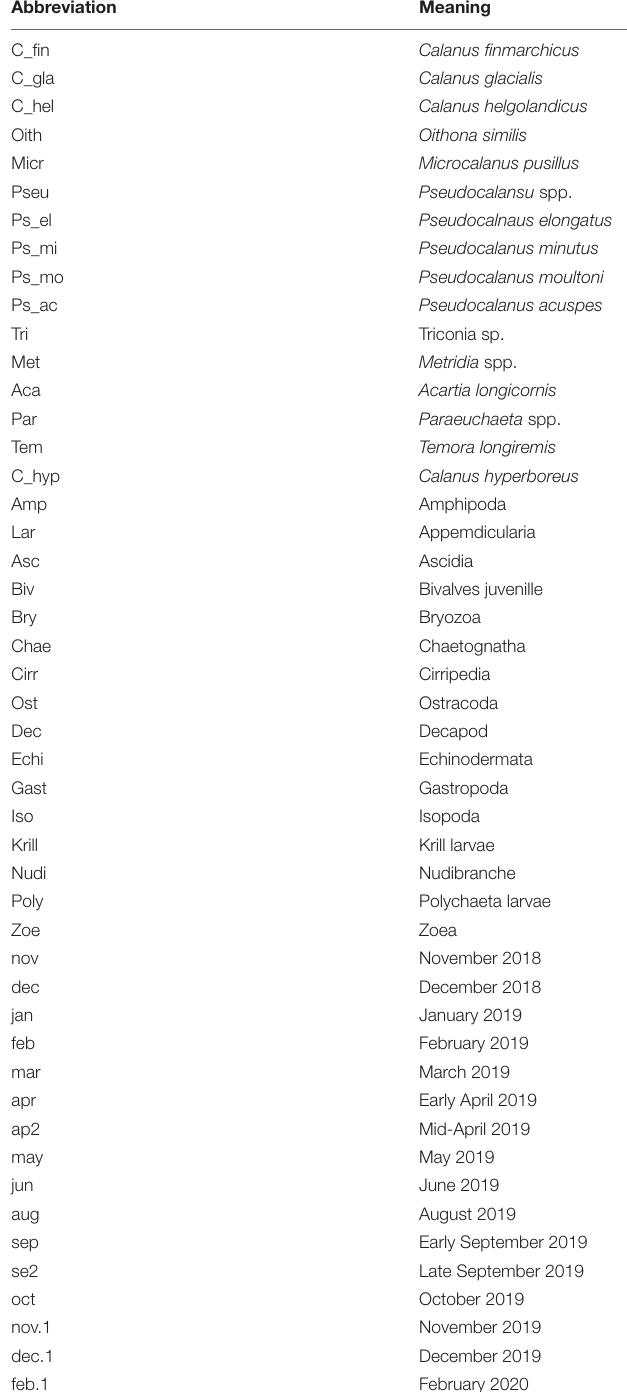
TABLE 4 | List of abbreviation used in the CCAs and their